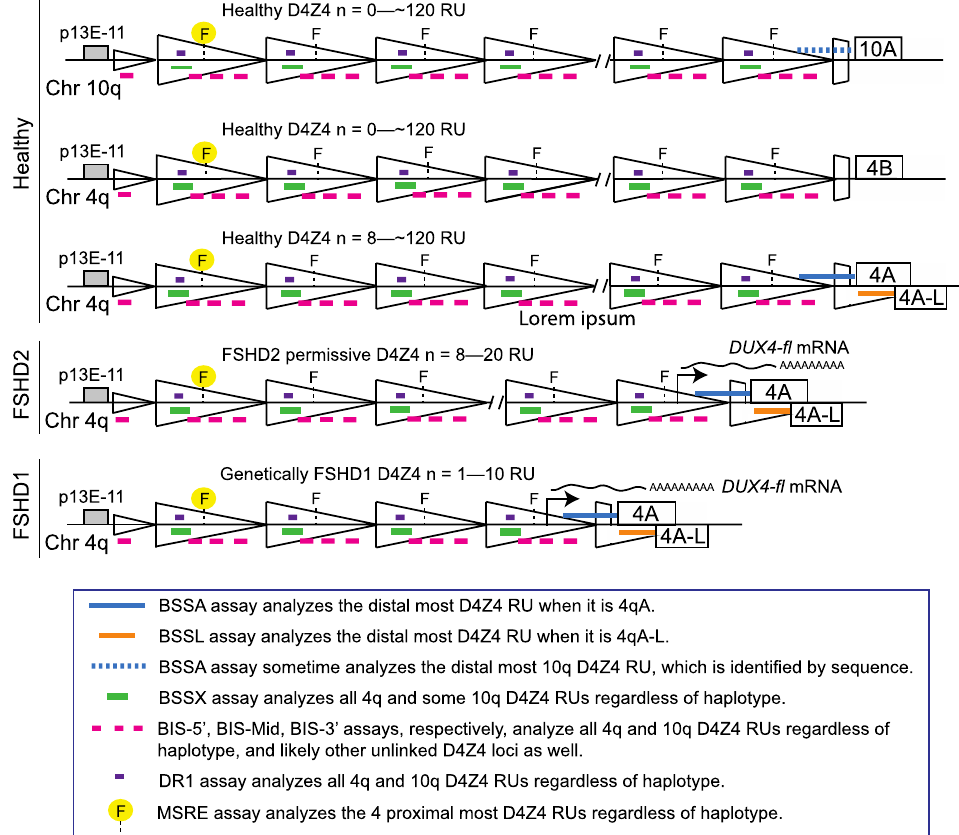
Figure 1. Schematic of FSHD-associated chromosome 4q D4Z4 regions analyzed by BSS (modified from [32]). The genomic regions assayed by the three most commonly used methods for FSHD diagnostics are shown. The methylation sensitive restriction enzyme (MSRE) digestion and Southern blotting method assays the methylation state of the most proximal Fse I restriction enzyme site (yellow highlight) on both alleles for the 4q and 10q chromosomes when probed with p13E-11 [25,30]. The DR1 BSS assay identifies FSHD2-specific DNA hypomethylation [33]. The BSS assays used by Gaillard et al. separately amplify three different regions of the D4Z4 (BIS-5′, BIS-mid, BIS-3′; pink) that are also present on both alleles of the 4q and 10q chromosomes [34]. In contrast, the BSS assays used by Jones et al. amplify two products that are specific for the distal-most chromosome 4q, one for 4qA alleles (BSSA, blue), and the other for 4qA-L alleles (BSSL, orange), and one product upstream of the DUX4 ORF that is present on all four alleles (BSSX, green) [32]. The genomic region amplified by the BIS-3′ assay is completely within the BSSA amplified region and the DR1 region is completely within the BSSX region.